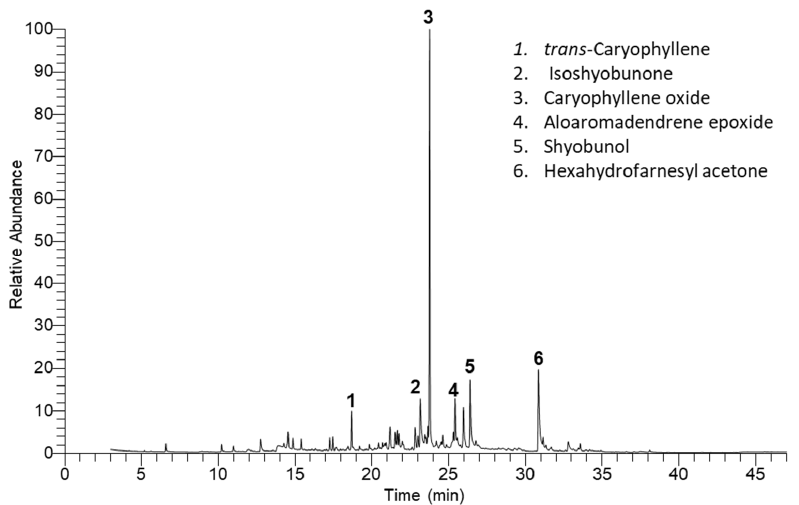
Figure 1. Chromatogram of the chemical compounds identified via GC-MS in the EO of Cleome amblyocarpa above-ground parts. The major compound peaks are numbered (1–6). Table 1. Chemical components of the essential oil of above-ground parts of Cleome amblyocarpa .